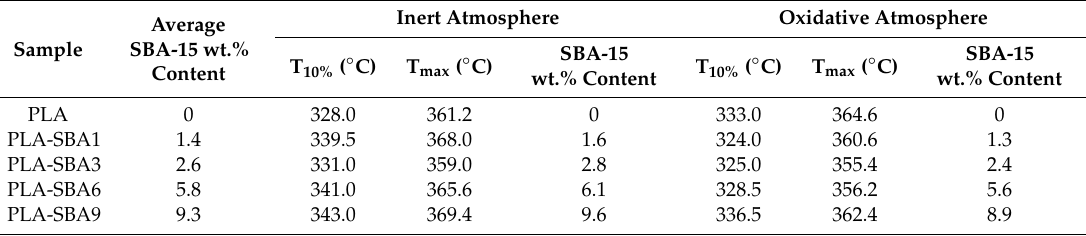
Table 1. TGA results under nitrogen and air atmospheres for neat PLA and composites prepared by melt extrusion: temperature of a loss weight of 10% (T 10% ) and temperature at the maximum (T max ), together with the SBA-15 wt.% content in both environments and its